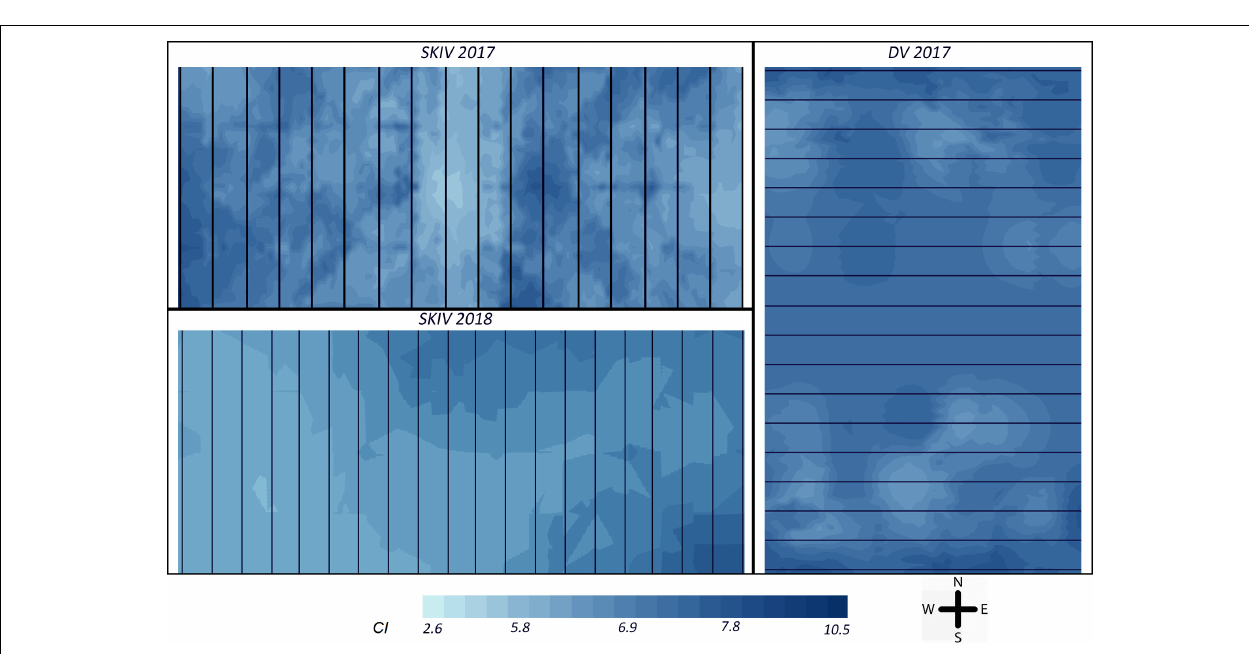
FIGURE 7 | Map of distribution of Condition Index = DW (mg)/SL 3 (cm), for all treatments over the experimental section of each farm (SKIV and DV). The top left panel represents SKIV in the 2017 growth cycle (belt spat collectors), the bottom left represents SKIV in the 2018 growth cycle (tube-nets), the right panel represents DV in the 2017 growth cycle (belt spat collectors). Black lines represent the longlines or tube-nets as oriented in each farm. Interpolation over the farm was conducted by ordinary kriging (Haas and Wackernagel,